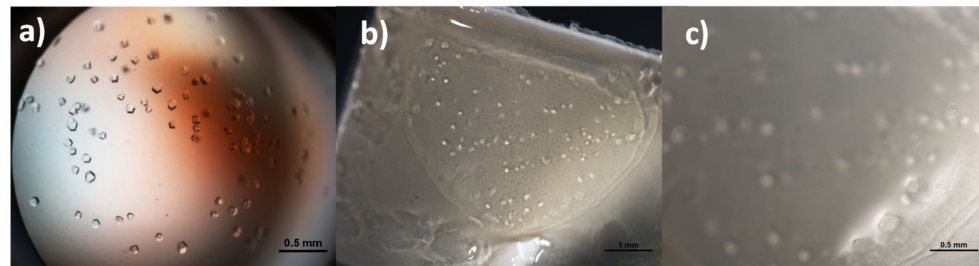
Figure 2. Crystals of glucose isomerase grown overnight on plastic sitting-drop supports ( a ) and on ionic-liquid based hydrogel membrane composites ( b , c ) with 5 %wt ionic liquid content of the monomer (IL-HCM 2). Image a is taken with the microscope in transmission mode, images b and c are taken in reflection mode at two di ff erent magnifications of the same